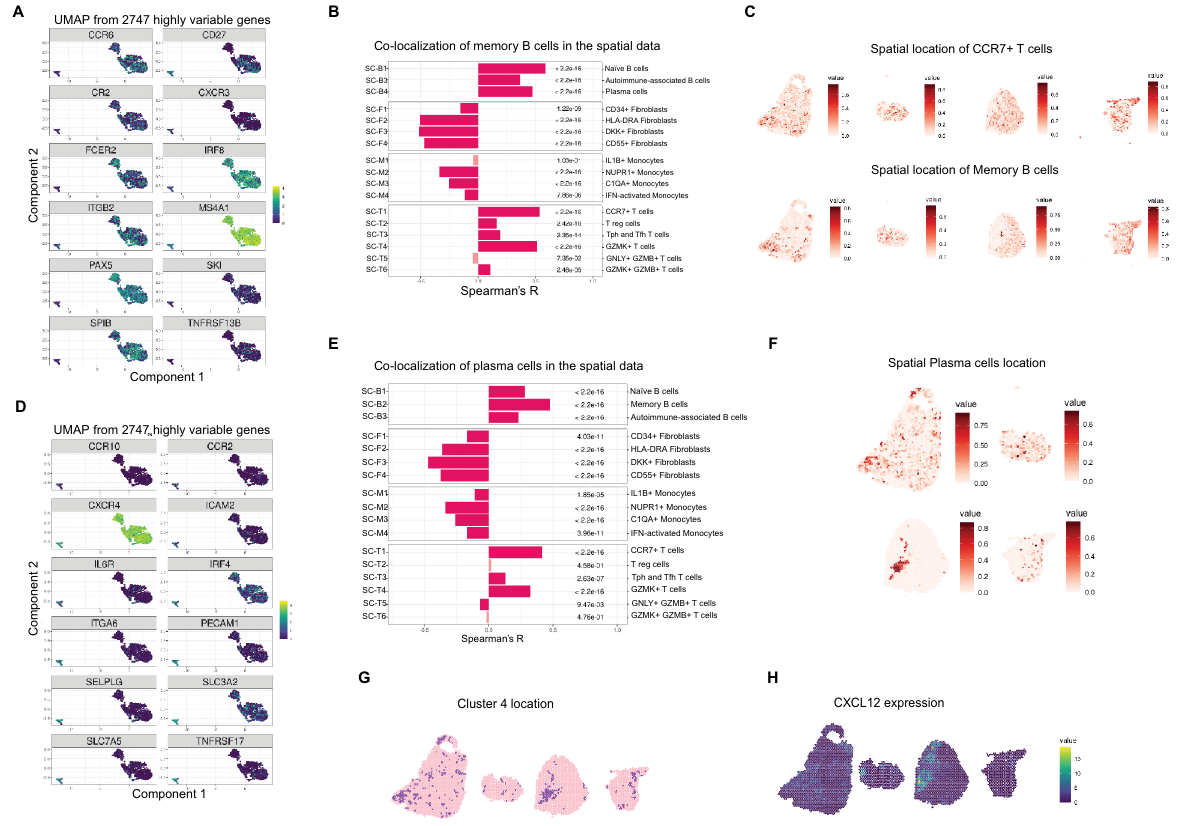
Figure 4. Memory B and plasma cell niches in synovial tissue at the time of diagnosis. ( A ) The memory cell markers are either shared with the naïve cells, such as CR2 encoding CD21 or FCER2 encoding CD23, or they are shared with the plasma cells, such TACI encoded by TNFRSF13B . ( B ) We determined correlation between the predicted location score of memory B cells (SC-B2) and the other clusters in the spatial data 17 . ( C ) The spatial distribution of memory B cells (SC-B2) and CCR7 + T cells (SC-T1) show a dispersed but correlating pattern. ( D ) We find expression of genes in plasma cells that are important for matrix interaction such as ICAM2 and ITGA6 encoding CD49f. We also find expression of CXCR4 and of BCMA encoded by TNFRSF17, which are important for the plasma cell niches. ( E ) We determined correlation between the predicted location score of plasma cells (SC-B4) and the other clusters in the spatial data 17 . ( F ) Plasma cells are confined and adjacent to the lymphocyte infiltrates. ( G ) We find overlap between the designated and the predicted plasma cell cluster. ( H ) Additionally, we find high CXCL12 expression in the plasma cell areas suggesting a niche in the inflamed